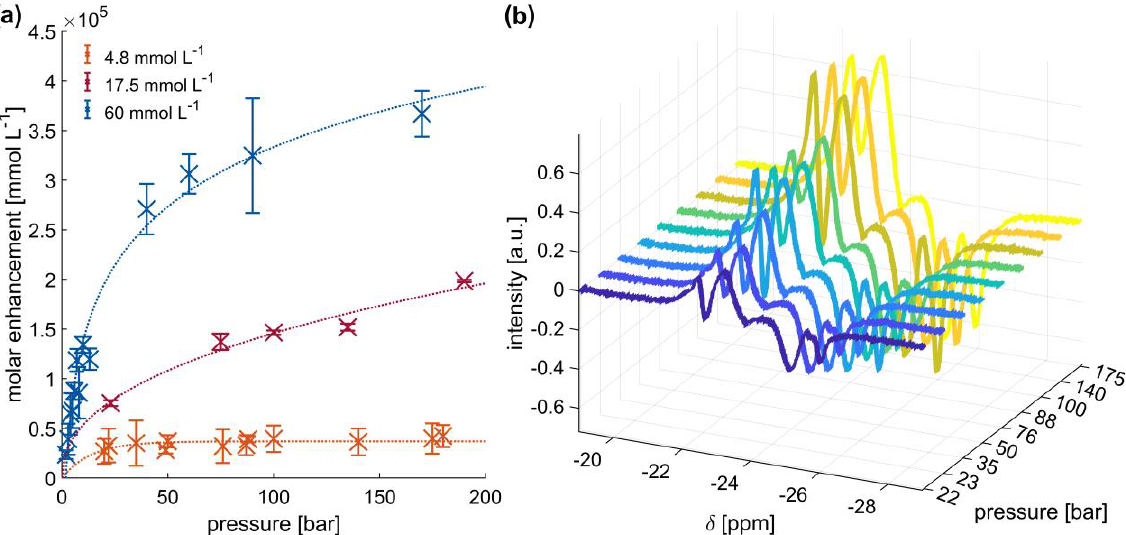
Figure 3. ( a ) Molar enhancements achieved with high-pressure SABRE hyperpolarization at differ- ent pyrazine concentrations in d -methanol. The pyrazine/catalyst ratio was 1/20. The thermal signal of a reference sample was used for determining the signal enhancement. The dotted lines serve as a visual guide. The measurement for each pressure point was conducted three times to determine the error bars. ( b ) Hydride signals of hyperpolarized solutions with 4.8 mmol L −1 pyrazine and 0.24 mmol L −1 catalyst at different pressures.